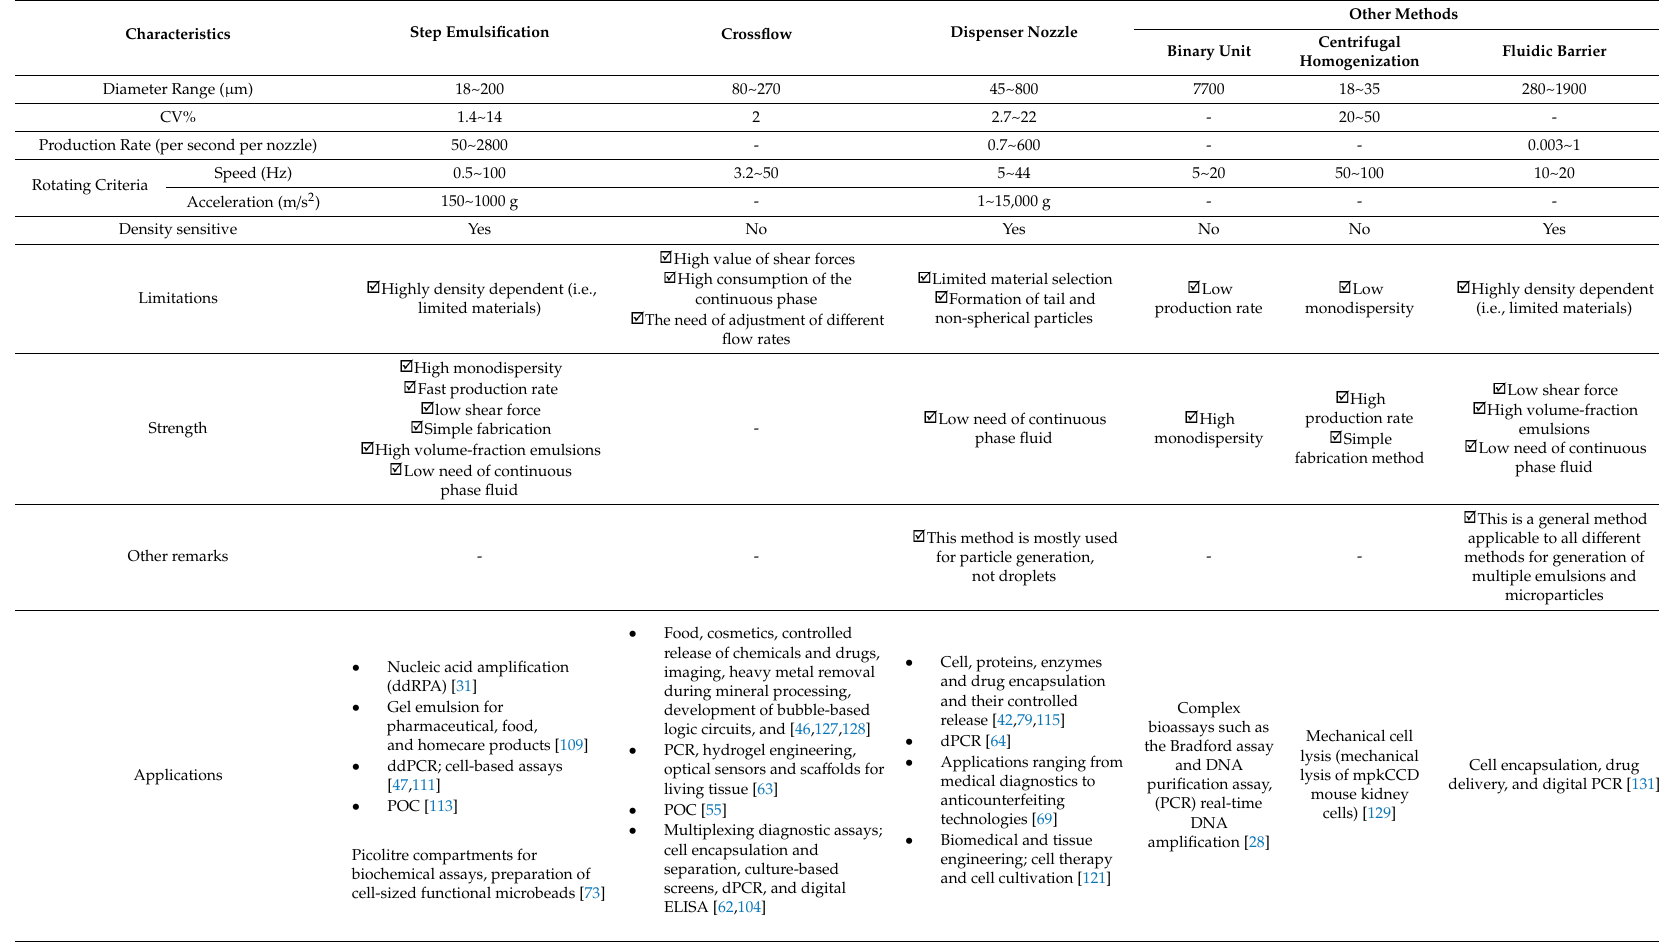
Table 4. Comparison of di ff erent methods of droplet / particle generation according to the previous studies in the